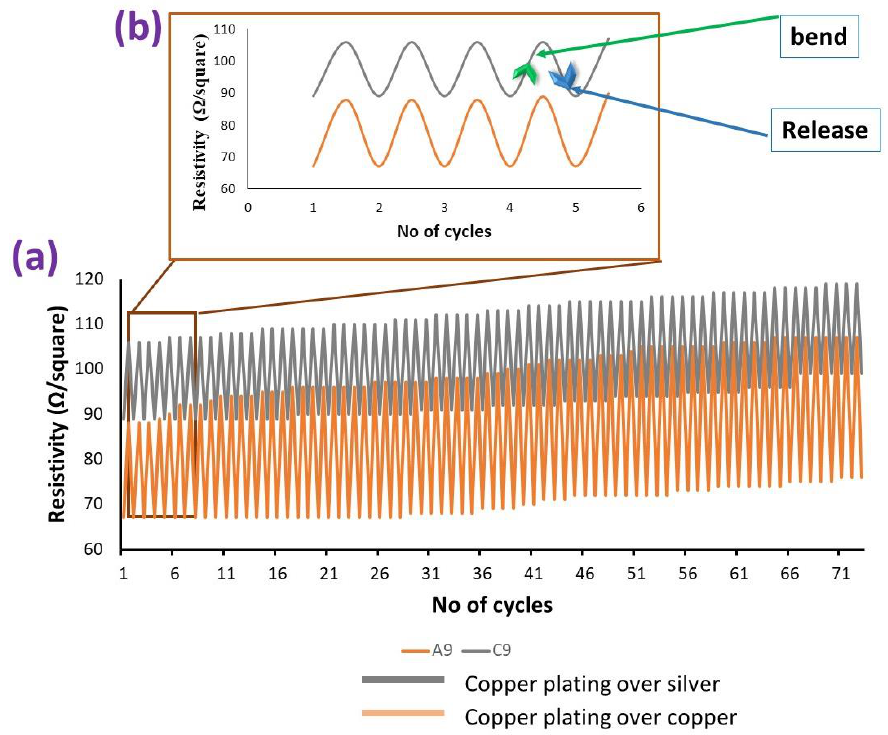
Figure 18. ( a ) Stability in resistivity during mechanical action of different no of cycles (bend and release), ( b ) blue and green arrows are representing the bend and release modes (with slightly shifted wavelengths to avoid from overlapping and for better understanding).